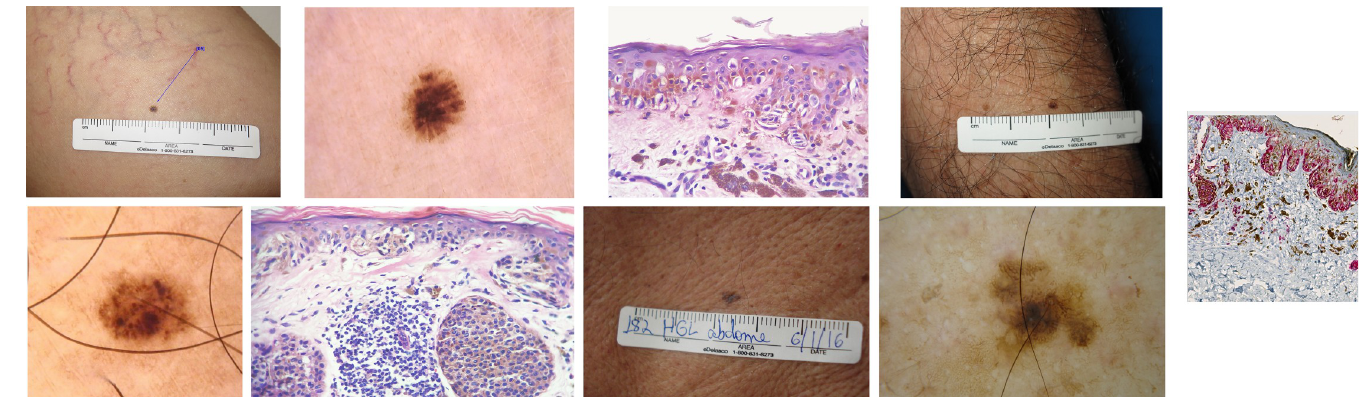
Fig 1. Case 1: Fig 1A: Clinically non-suspected lesion; Fig 1B: Suspected dermoscopy lesion with asymmetric structureless area; Fig 1C: H&E (Hematoxylin & Eosin 40X) Melanocytic lentiginous proliferation with small junctional nests. Some melanocytes adopt a supra-basal position. In the dermis, mononuclear inflammatory infiltrates include melanophages. Conclusion: 2mm diameter melanoma, Breslow 0.2mm. Case 2: Fig 1D: Clinically suspected lesion. Fig 1E: Suspected dermoscopy lesion with asymmetric globules; Fig 1F: H&E (40X) Melanocytes with hyperchromatic nucleus, enlarged, and moderately pleomorphic. They form nests of varied size where they are eventually horizontal. Intradermal nests consist of cells with mild pleomorphism adjacent to predominantly lymphocytic inflammatory infiltrates. Conclusion: 3mm diameter melanoma, Breslow 0.4mm. Case 3: Fig 1G: Clinically suspected lesion. Fig 1H: Suspected dermoscopy lesion with atypical asymmetrical pigmentary network. Fig 1I: Immunohistochemistry with Melan A (10X), showing the junctional melanocytic proliferation, the migration of melanocytes to the layers of the epidermis and the presence of Melan A positive cells in the dermis (loose), amid the mononuclear inflammatory infiltrate with melanophages. Conclusion: 5mm diameter melanoma, Breslow